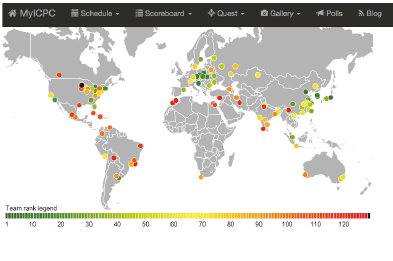
Figure 8: Interactive score world map.